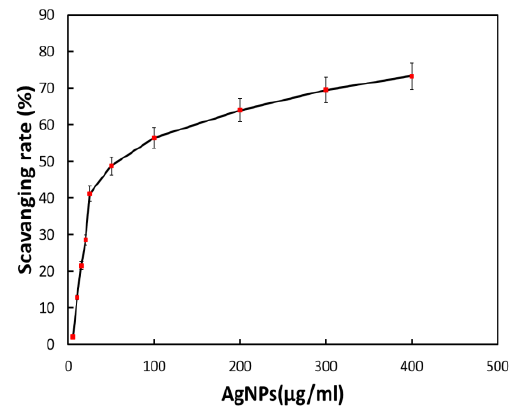
Figure 7. The effect of AgNPs on the DPPH assay-based scavenging under increasing concentra- tions.